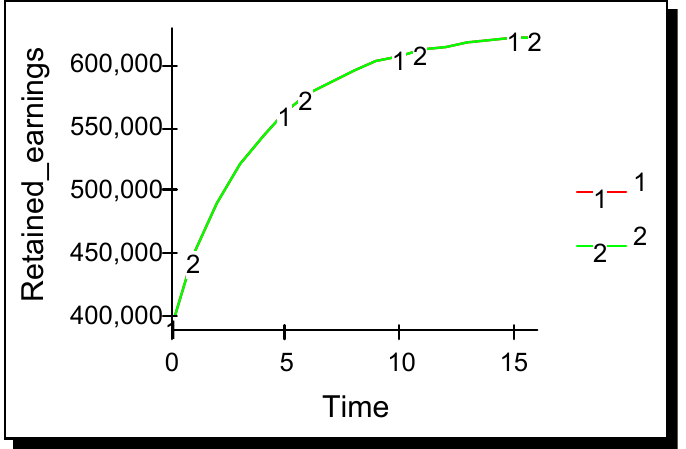
Figure 5. Symmetric advertising, below threshold. Advertising effectiveness: φ 1 = φ 2 = 0.000010.